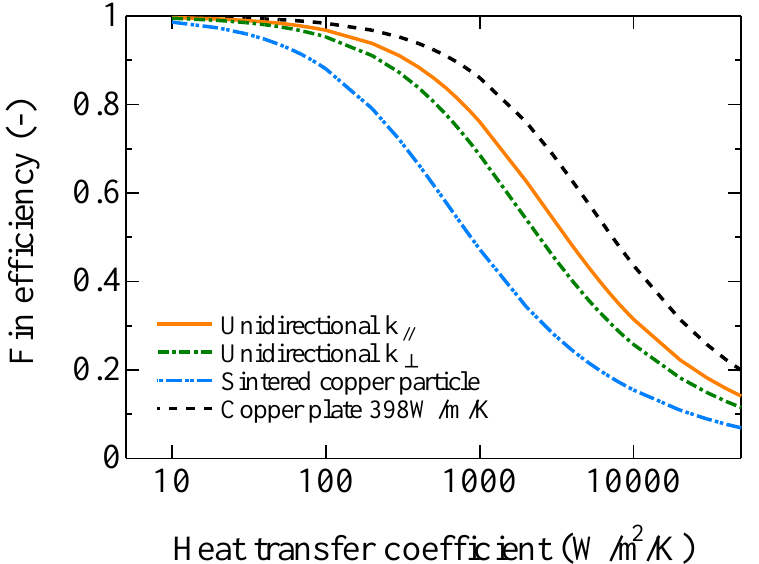
Figure 4. Fin efficiency of sintered copper-particle and unidirectional porous copper.